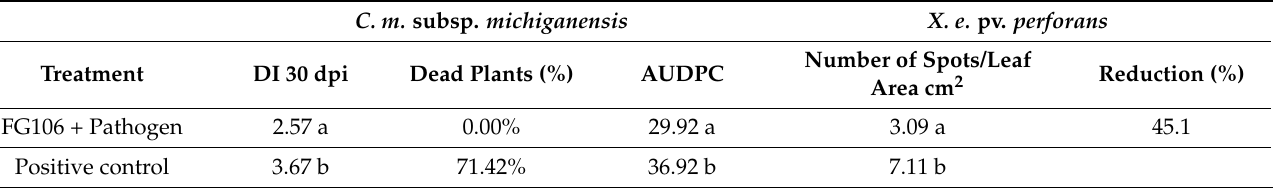
Table 4. Disease index, dead plant percentage, number of spots per cm 2 leaf area, and reduction percentages for tomato seedlings challenged with the pathogen C. m. subsp. michiganensis and X. e. pv. perforans with and without simultaneous treatment with